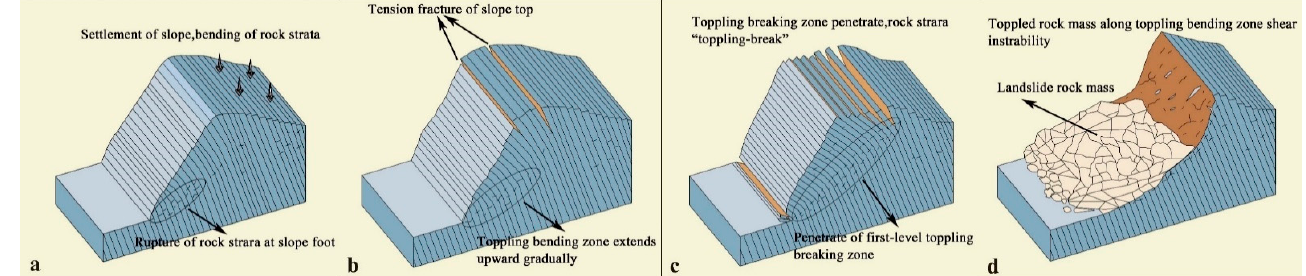
Figure 13. “Toppling–shear slide” disaster pattern.( a ) settlement of slope bending of rock strata, ( b ) tension fracture of slope top, ( c ) penetrate of first-level toppling breaking zone, ( d ) toppled rock mass.